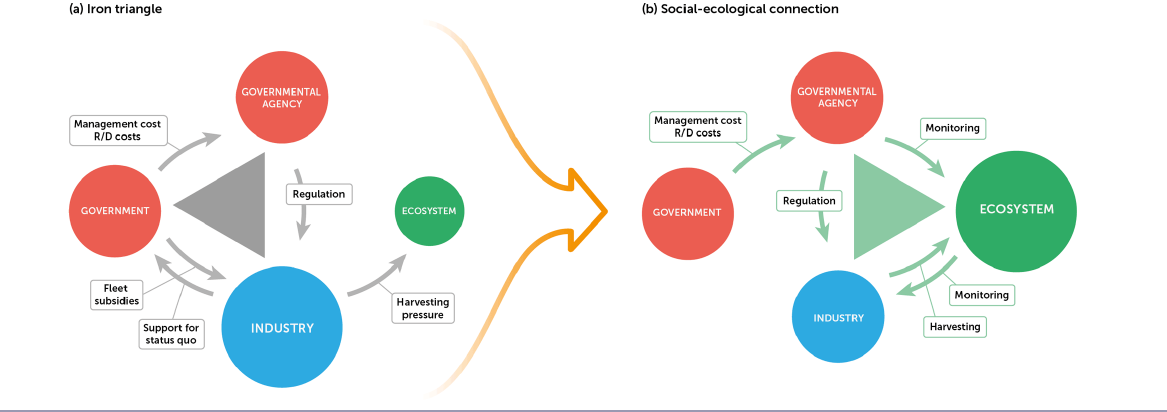
Fig. 8 . Conceptual model of (A) the main dynamics for the pre-EU period as described in this paper, and (B) a possible alternative system dynamic without subsidies. In (A), the “iron triangle” of the government, the agency, and the industry creates a reinforcing feedback that boosts the size of the industry and simultaneously the need for regulation, resulting in an increased bureaucracy. By consequence, the environment is externalized. In (B), fleet subsidies are suspended, and the size of the industry is more directly dependent on the ecosystem. Consequently, the iron triangle is replaced by a social-ecological (re) connection, with the ecosystem internalized and thereby possibly fostering resource stewardship among the industry